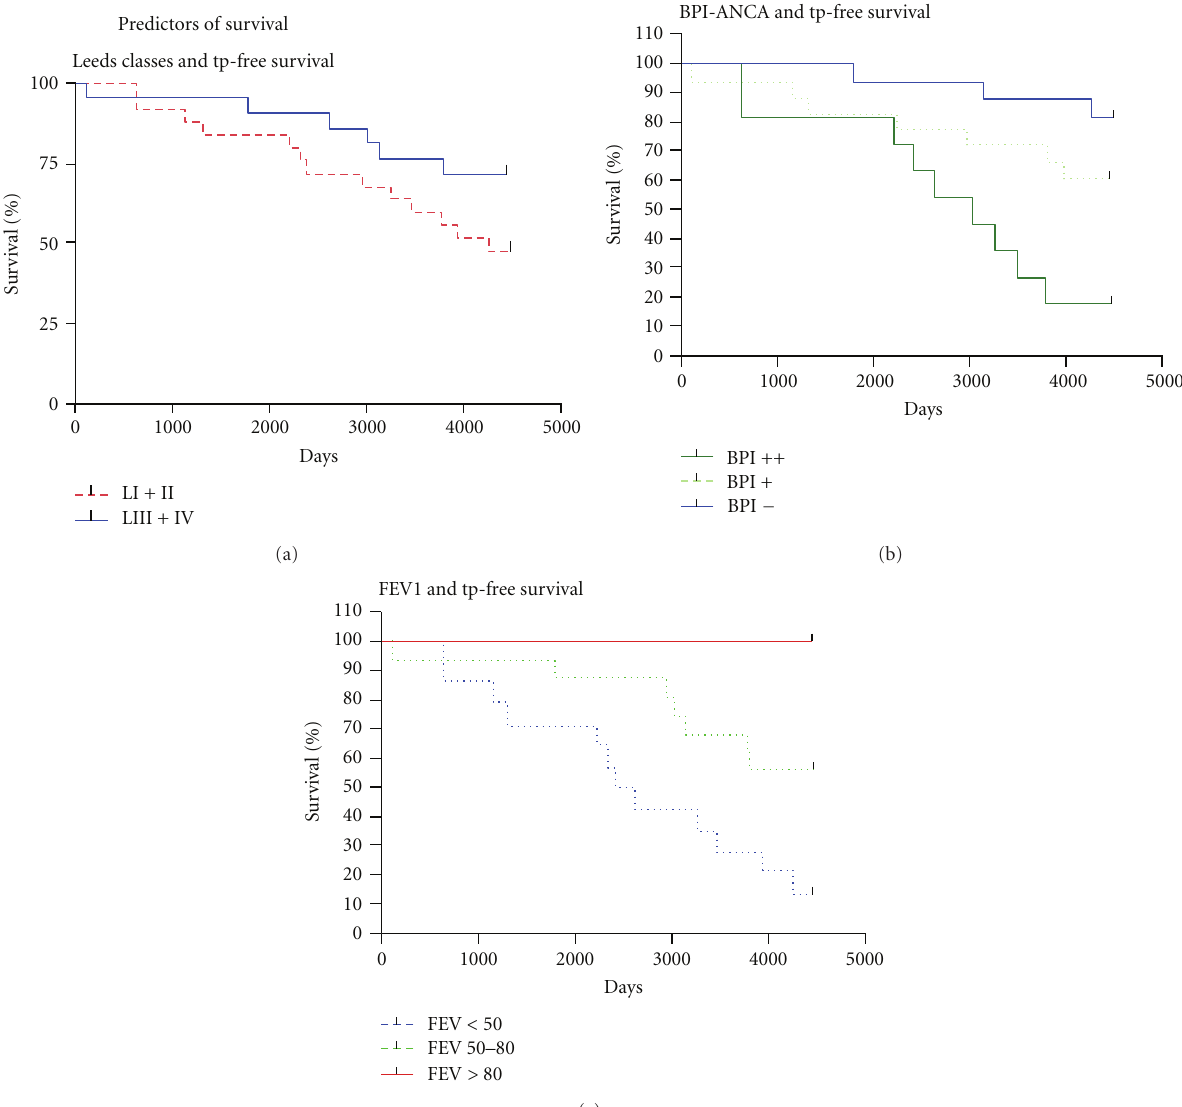
within ten years compared to two out of 10 patients with lower ANCA